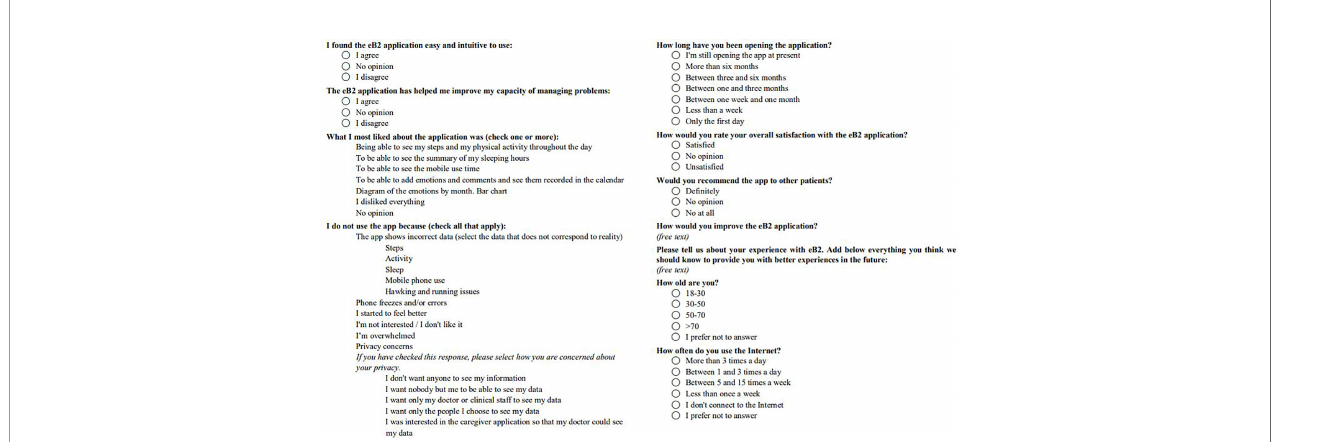
FIGURE 2 | Patient app use and satisfaction